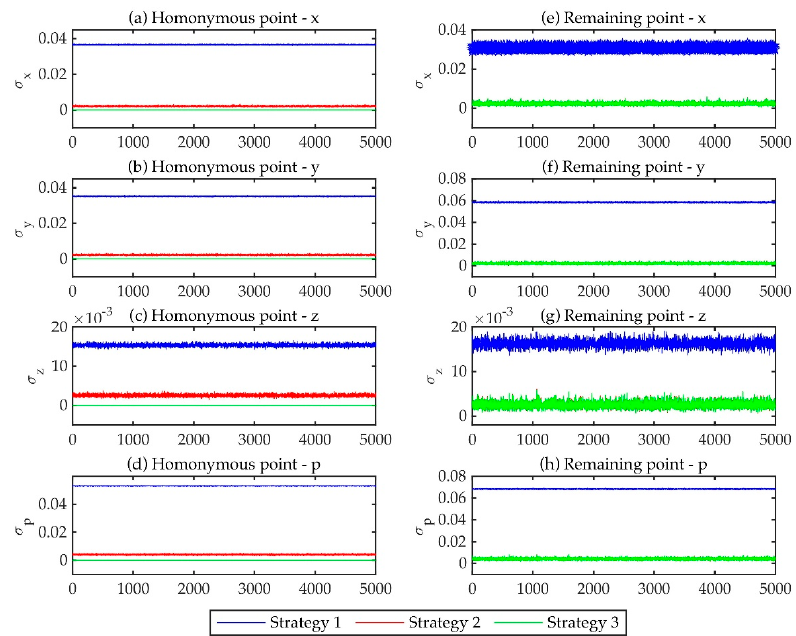
Figure 5. RMSE of points in Case 1, where the horizontal axis indicates the experimental serial number. ( a ) RMSE of homonymous points in x direction; ( b ) RMSE of homonymous points in y direction; ( c ) RMSE of homonymous points in z direction; ( d ) positional RMSE of homonymous points; ( e ) RMSE of checking points in x direction; ( f ) RMSE of checking points in y direction; ( g ) RMSE of checking points in z direction; ( h ) positional RMSE of checking points.